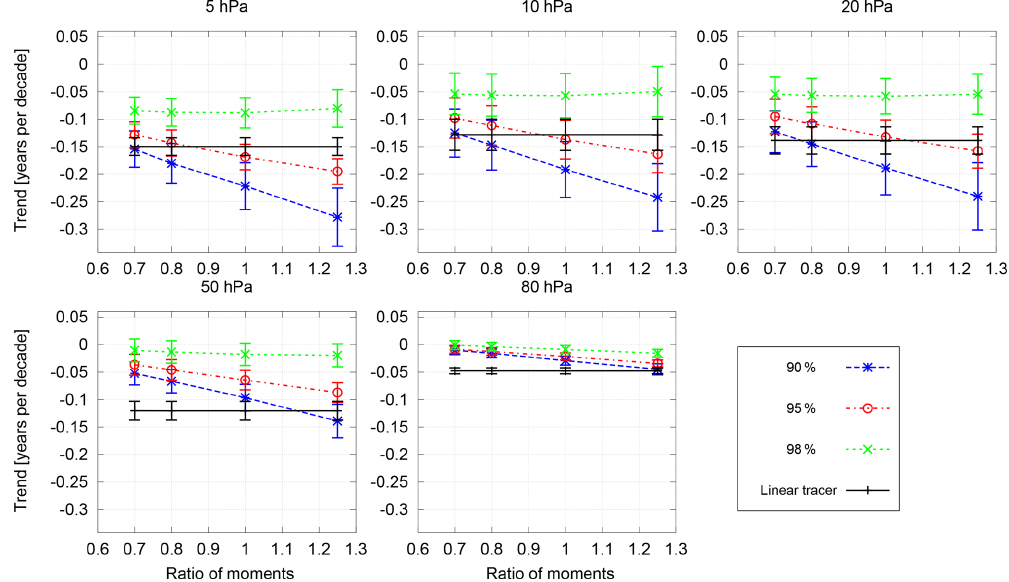
Figure 7. Overview of the trend in mean AoA derived from SF 6 (dotted lines) and a linear tracer (solid line) for different ratios of moments ( x -axis) and fractions of input (colours) at 40 ◦ N. The panels show different pressure levels. The trend calculation considered the time series from 1975 to 2011. The error bars show 1 σ which is the 68% confidence